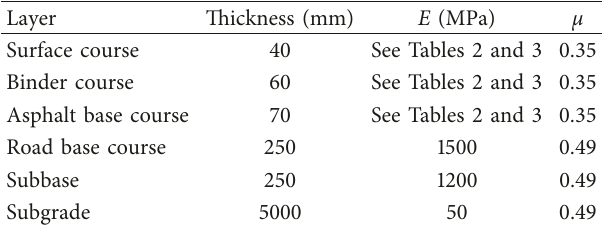
Table 3: Prony series parameters used in